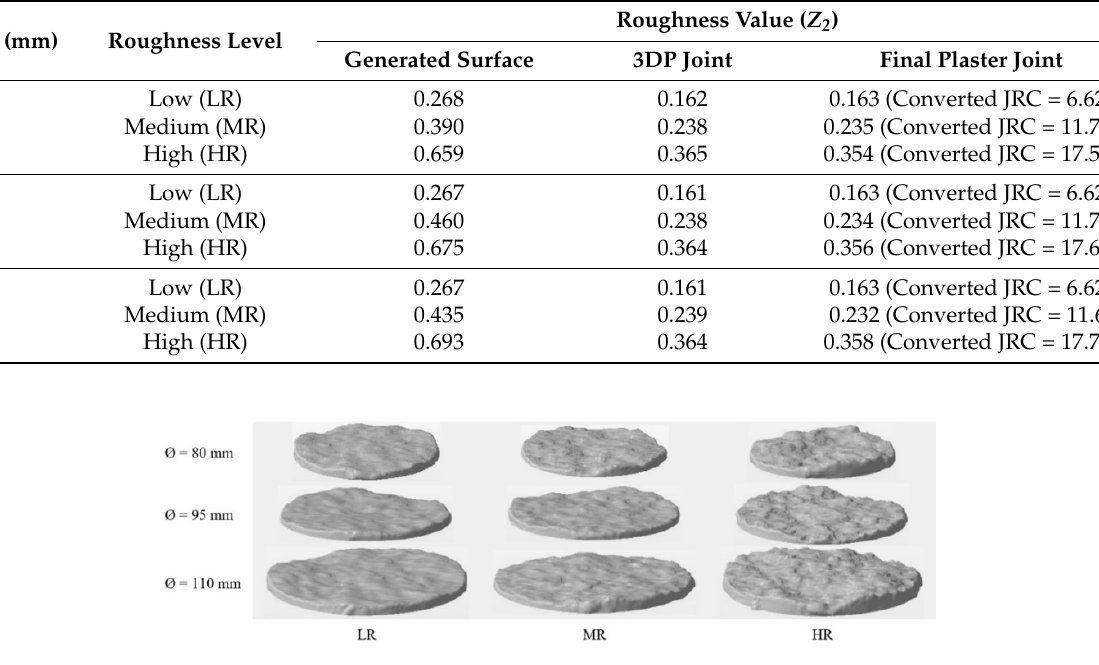
Figure 3. Surfaces of final plaster joints at three levels of roughness. 2.4.2. Specimens Containing a Single Non-Persistent Open Joint (Br specimens) Several rectangular cuboid plaster specimens (length: 150 mm, width: 115 mm, height: 130 mm) with a single non-persistent open joint were cast to investigate the shear behavior of rock bridge. The preparation process of Br specimens is illustrated in Figure